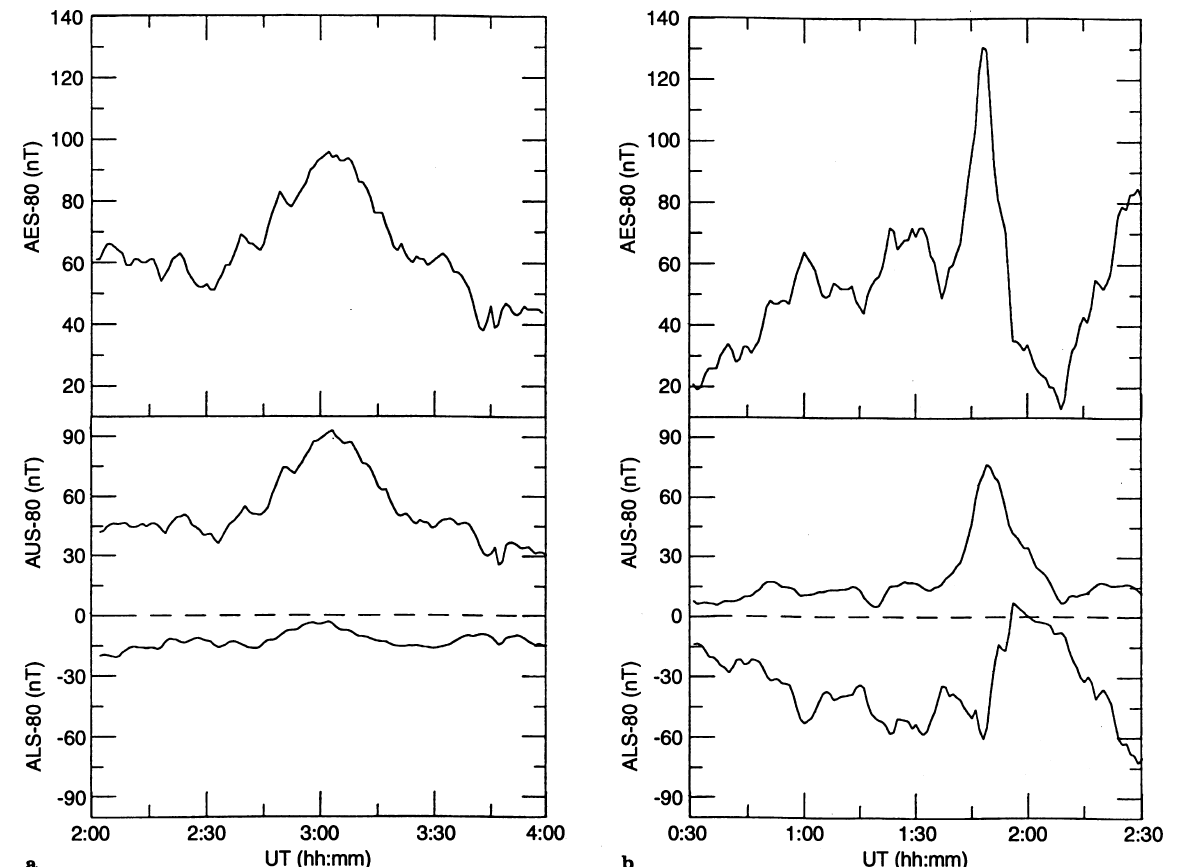
Fig. 7a,b. Plot of AES-80, ALS-80 and AUS-80 for two specific periods with high activity in AES-80 on a May 1st and b May